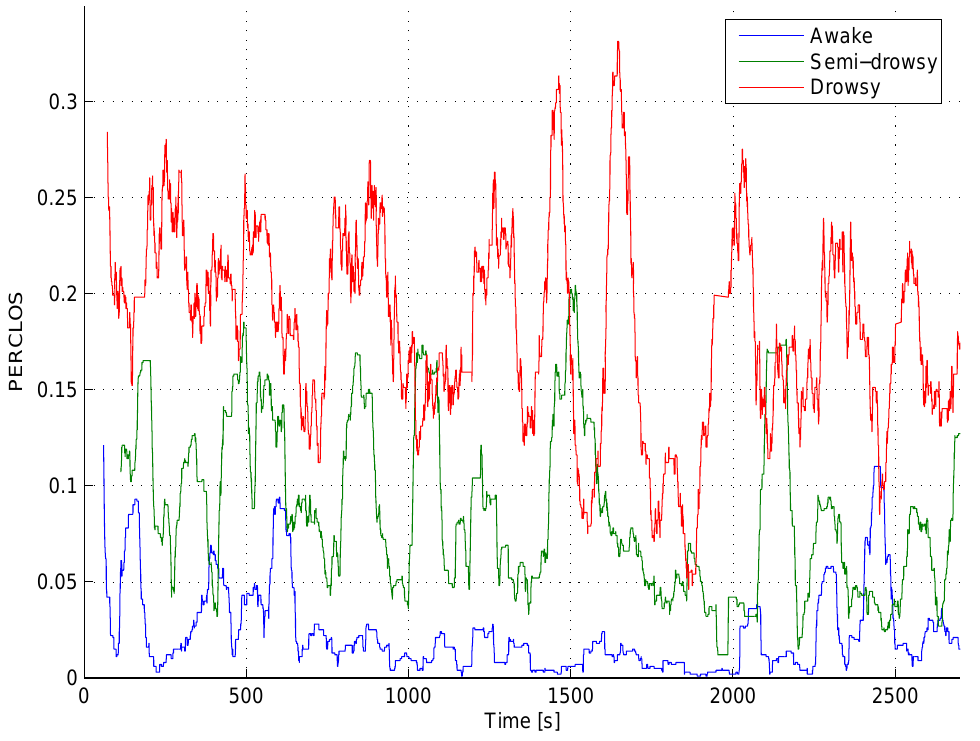
Figure 13. PERCLOS for the awake ( a ); semi-drowsy ( b ) and drowsy ( c ) drivers, corresponding to test subjects 1, 6 and 11,